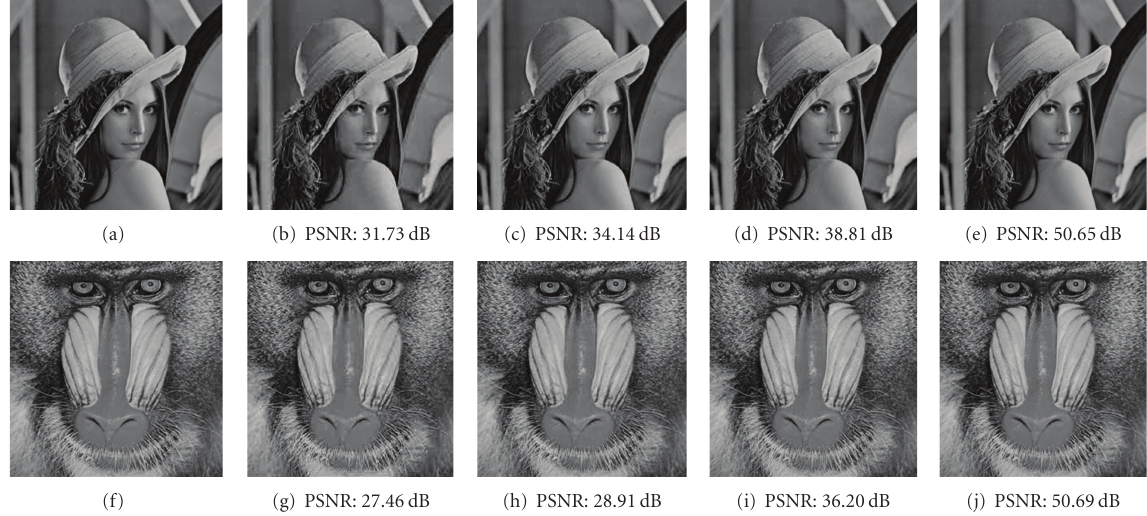
Figure 8: (a) Original Lena image; (b) reconstructed image using VC-1/MPEG-2/4; (c) using JPEG; (d) using H.264; (e) using AVS; (f) original Mandrill image; (g) reconstructed using VC-1/MPEG-2/4; (h) using JPEG; (i) using H.264; (j) using AVS.